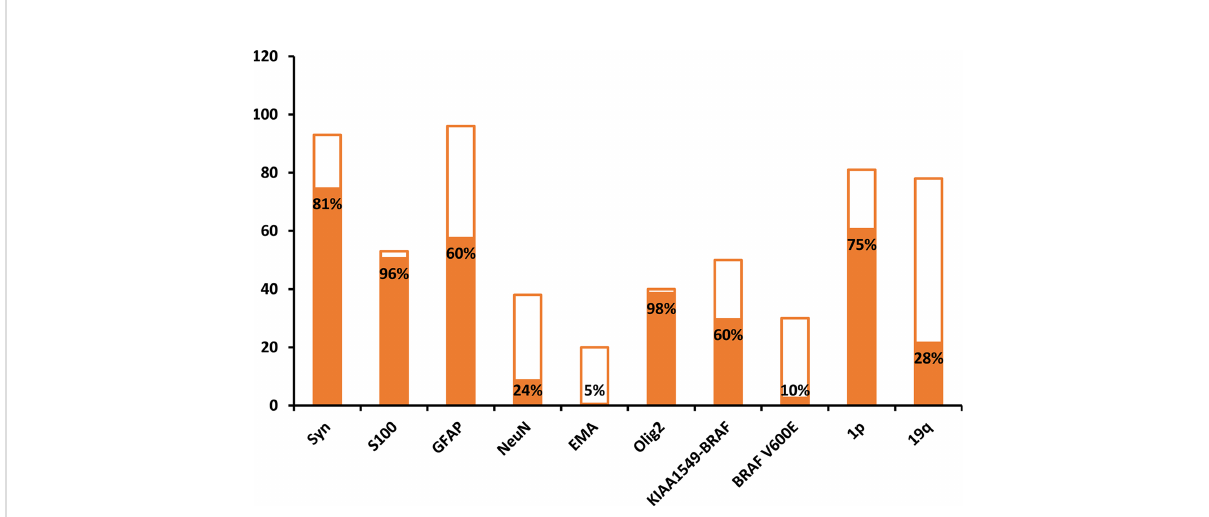
FIGURE 3 Analysis of immunohistochemical and molecular markers in patients with diffuse leptomeningeal glioneuronal tumors. Y-axis stands for the number of cases, and the solid bars represent the percentage of positive